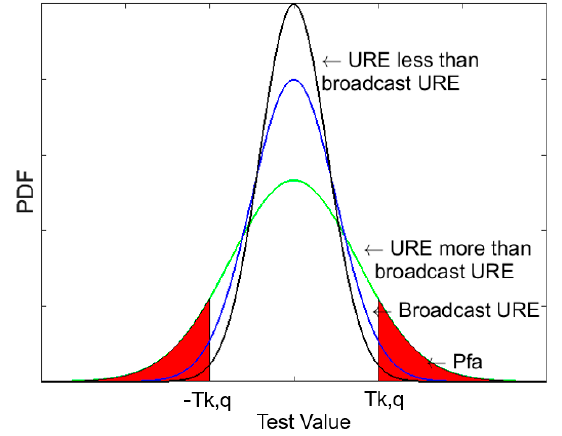
Figure 6. Probability density function of the fault detection test.